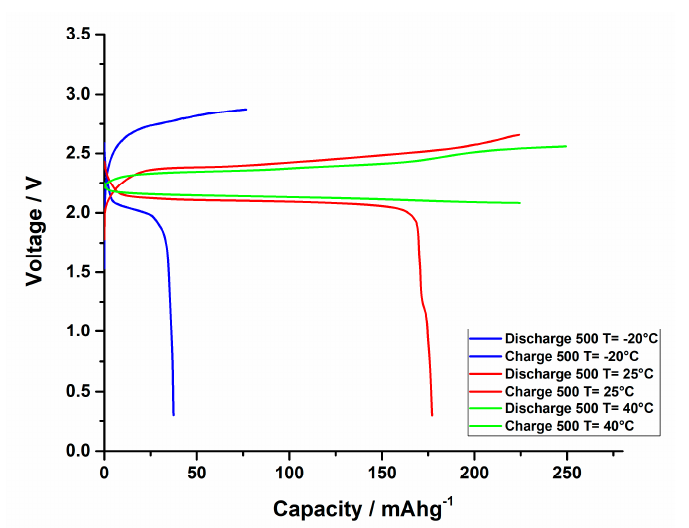
Figure 11. Comparison between charge and discharge curves (500th cycle) at different temperatures.